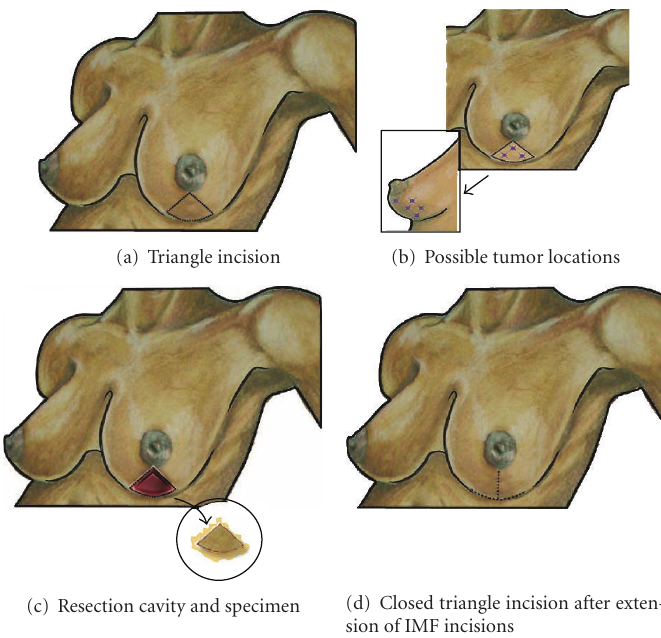
Figure 10: Triangle resection. (a) Shows location of the triangular skin incision. (b) Shows multiple “stars” indicating possible tumor locations suitable for this approach. (c) Shows resection cavity following excision of malignancy with excised specimen (inset). (d) Shows breast following closure of the skin incision, including extensions of incision along the inframammary skin